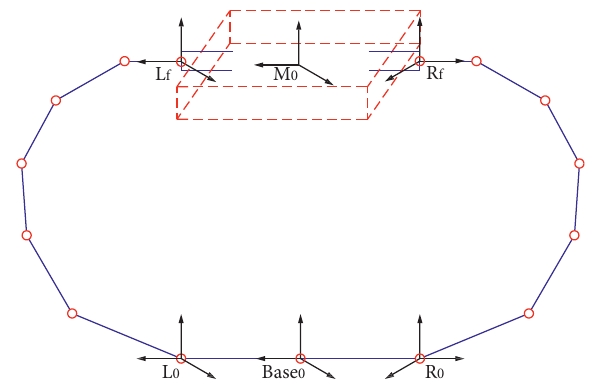
Figure 1: Sketch diagram of dual-arm cooperation